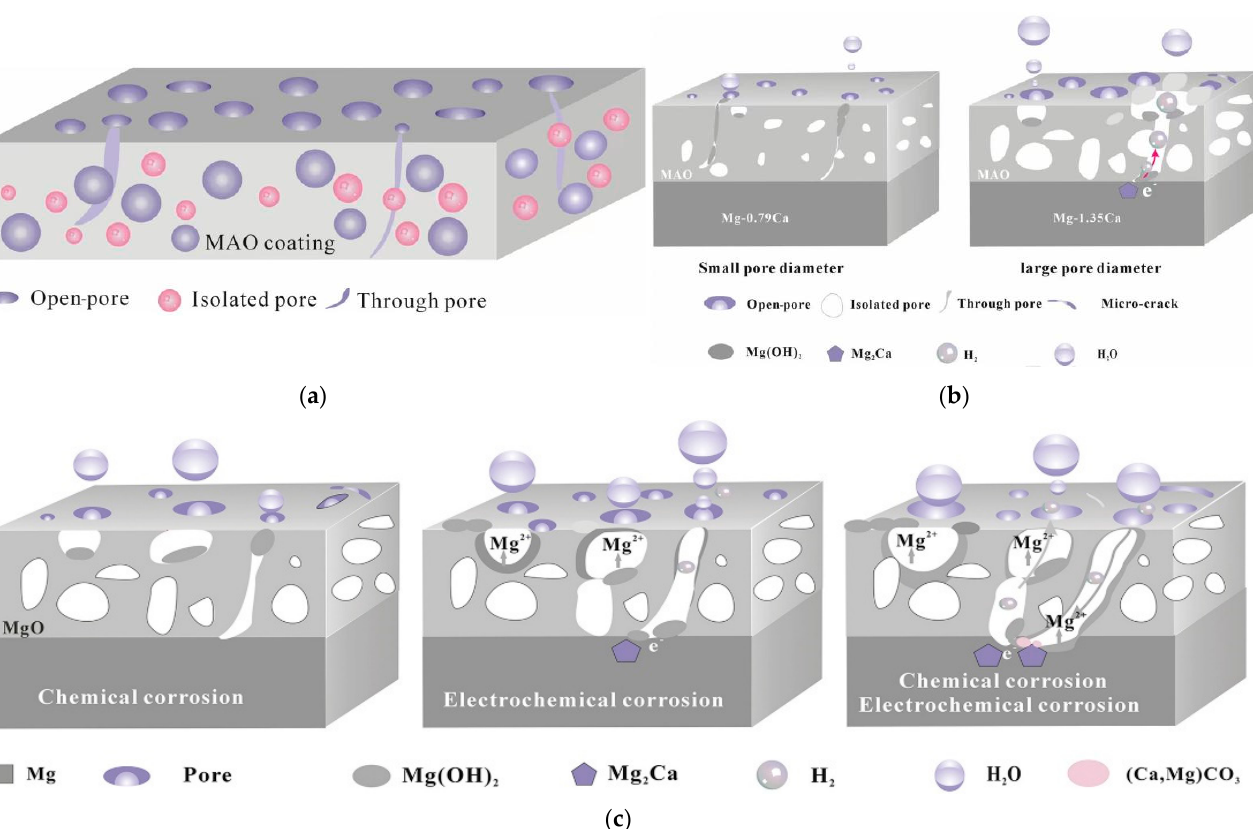
Figure 9. ( a ) Schematic illustration of the various pores in the MAO coatings on Mg alloys; ( b ) Schematic illustrations of the influence of pore diameter on corrosion; ( c ) Schematic illustrations of the chemical degradation [97]. Reprinted from J. Alloys Compd., 695, Cui, L.Y.; Zeng, R.C.; Guan, S.K.; Qi, W.C.; Zhang, F.; Li, S.Q.; Han, E.H., Degradation Mechanism of Micro-Arc Oxidation Coatings